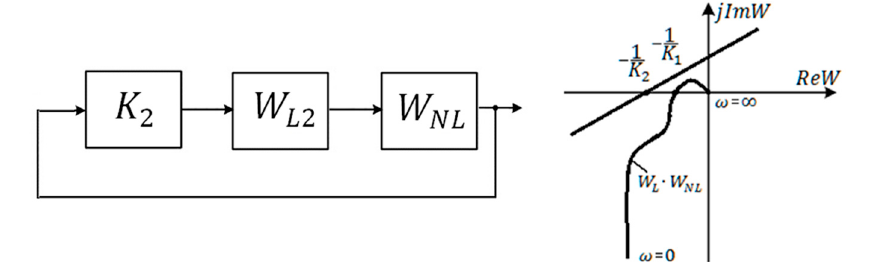
Figure 17. Structure and hodograph of a nonlinear stable ACS.